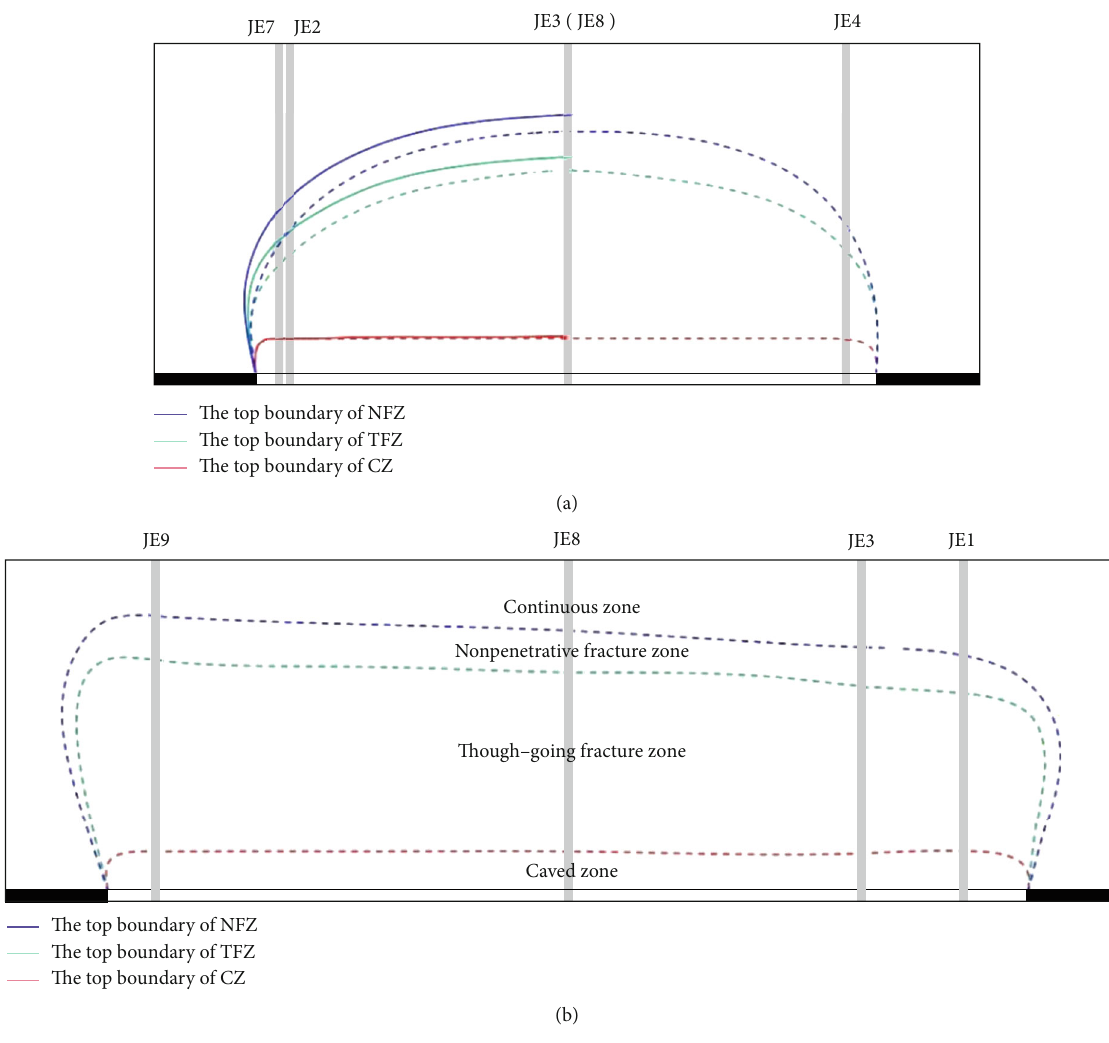
Figure 8: Pro fi les of top boundaries of CZ, TFZ, and Table 5: Top boundary depths and heights of the NFZ in boreholes.